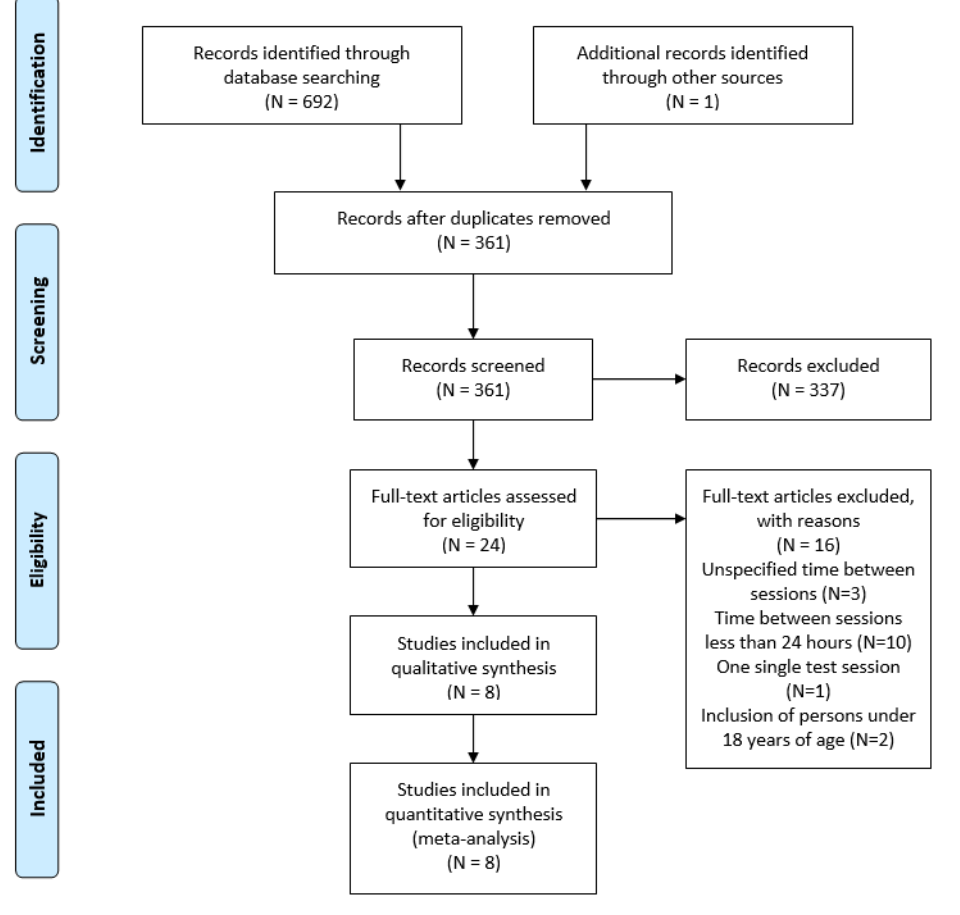
Figure 1. PRISMA flow diagram for study selection process.